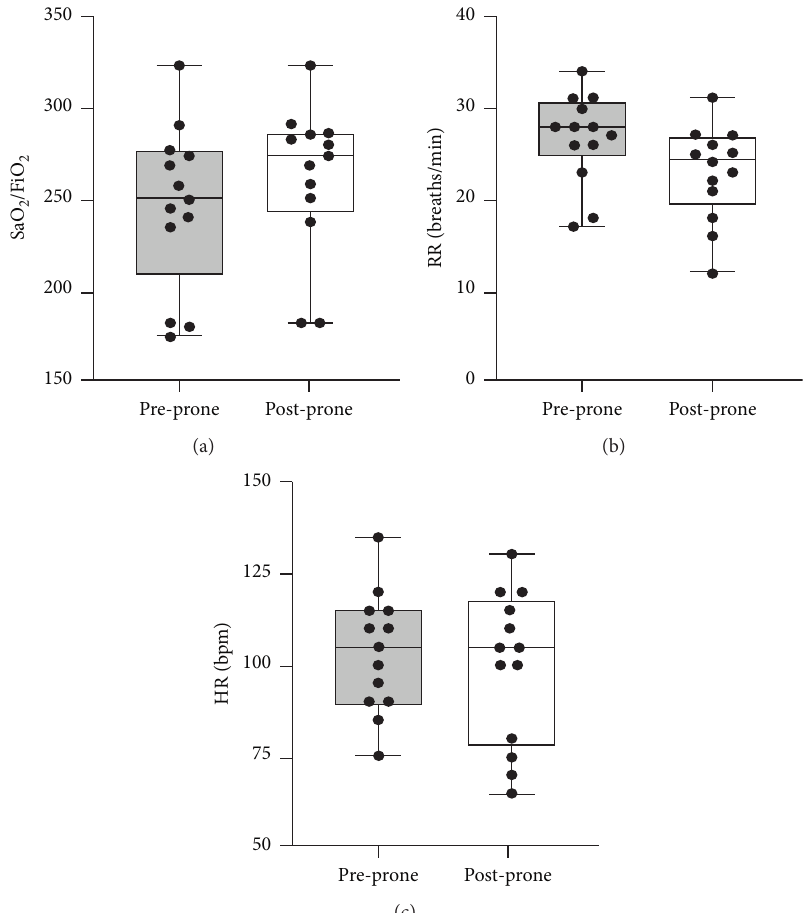
Figure 3: Aggregate patient values for SaO 2 /FiO 2 , RR, and HR prior to and following each prone positioning session.